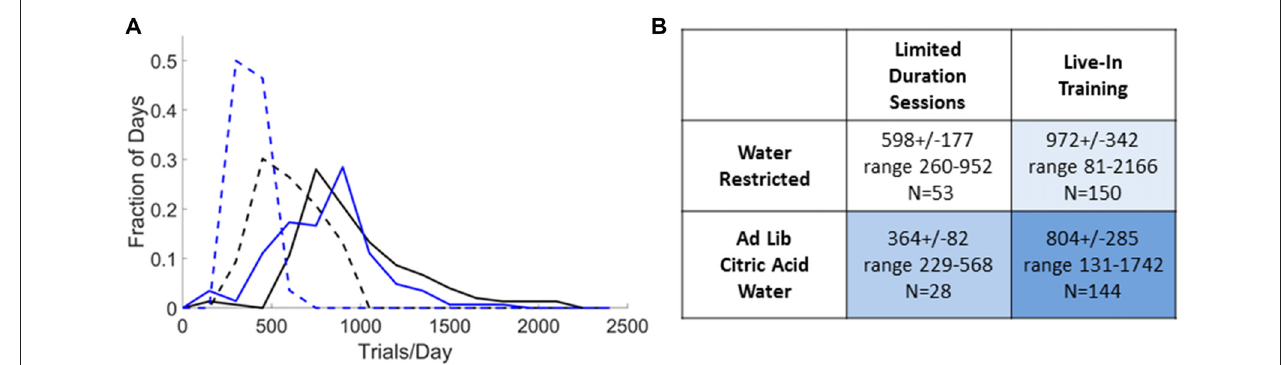
FIGURE 5 | Trial rates achieved in practice. (A) Distribution of trial rates obtained over all sessions that used small rewards ( < 25 µ l) for N = 10 expert rats, excluding the first day after switching from one training condition to another. For limited-duration sessions (dashed lines) we included all sessions 2–6 h in duration preceded by >12 h off task. The qualifying sessions had durations of 2.8 ± 0.6 h (Restricted, black) or 2.4 ± 0.3 h (with CA, blue). For live in training (solid lines) we included all sessions 18–30 h in duration preceded by < 6 h off task. The qualifying sessions had durations of 22.8 ± 2.4 h (Restricted, black) or 23.5 ± 3.1 h (with CA, blue). (B) Summary statistics of distributions in (A) . Shading indicates 24 h/day access to water requiring task engagement (pale blue), from a water bottle (medium blue) or both (dark blue).